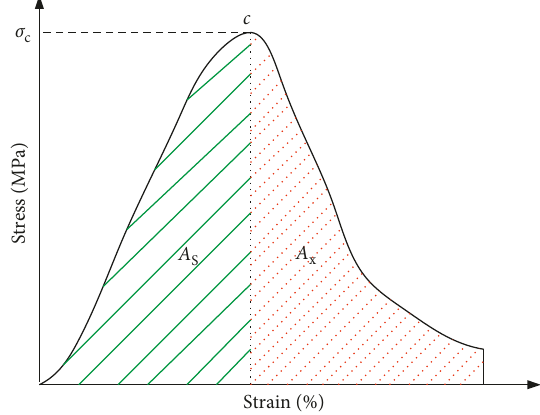
Figure 9: Calculation chart of ?